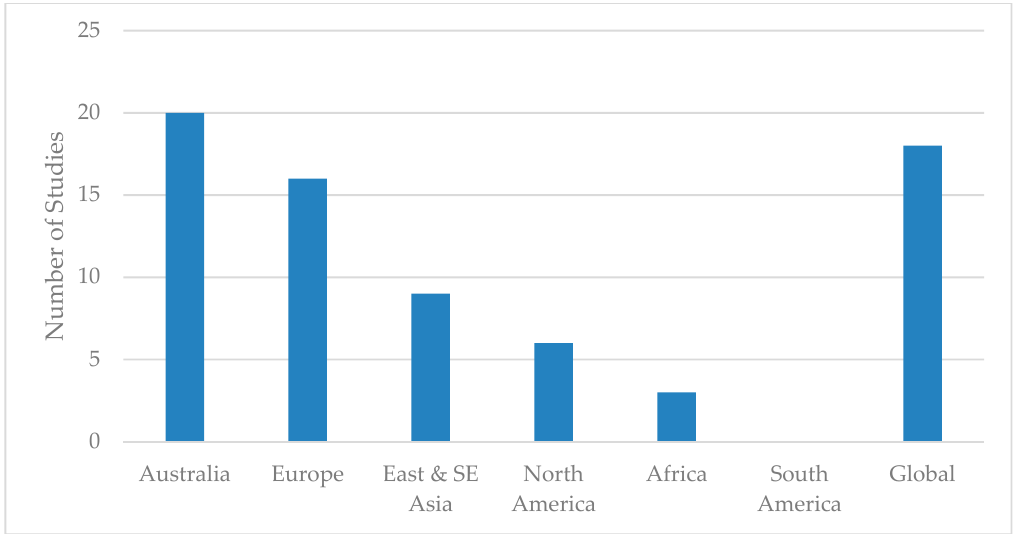
Figure 4 . Number of studies that report on linkages between urban livability and PGI spaces by the continent or geographic region identified from the article and the number of globally focused studies (i.e. editorial or review style articles) identified by the initial search. Transnational, international, and continent scale studies are recorded against the relevant continents or geographic regions.